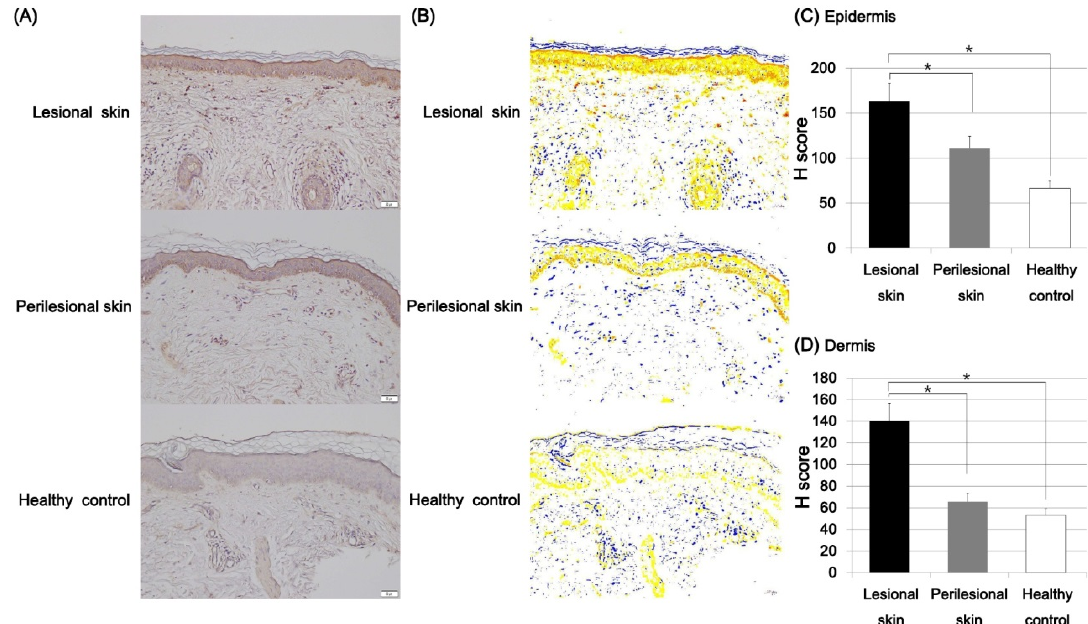
Figure 6. Expression profiles of endothelin (ET)-1 in the lesional and perilesional skin of Riehl’s melanosis and healthy controls. ( A ) The expression of ET-1 was increased in the lesional skin of Riehl’s melanosis (original magnification, 200 × ). Scale bar, 50 µ m. ( B ) Densitoquant TM quantitatively measured the intensity of ET-1 expression in Riehl’s melanosis and healthy control as follows: red, strong positive; orange, moderately positive; yellow, weakly positive; white and blue, negative. ( C ) The mean H score for epidermal ET-1 expression intensity was quantitatively analyzed in the lesional and perilesional skin of Riehl’s melanosis and healthy controls. ( D ) The mean H score for ET-1 expression intensity in the dermis was quantitatively analyzed in the lesional and perilesional skin of Riehl’s melanosis and healthy controls. * indicates a p -value of less than 0.05.